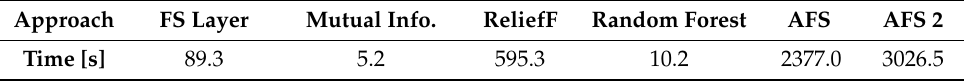
Table 10. Time duration for feature importance values generation (CWR case). For the embedded techniques (FS layer, AFS and AFS 2), this value is calculated as the difference between the total training time and the training time for a vanilla model without any embedded techniques. For the random forest technique, this value corresponds to the total training time, as there is no way to identify how much time it takes to obtain the desired values.